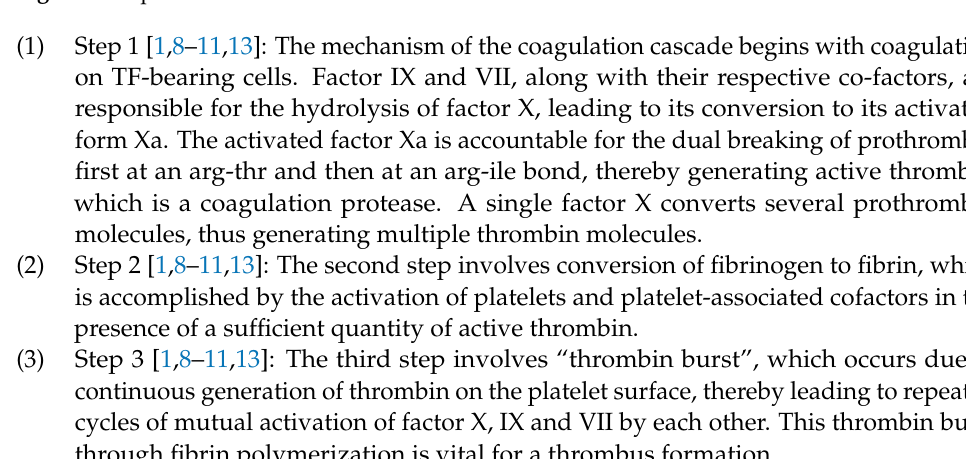
Figure 1. Depiction of mechanism of thrombus formation.